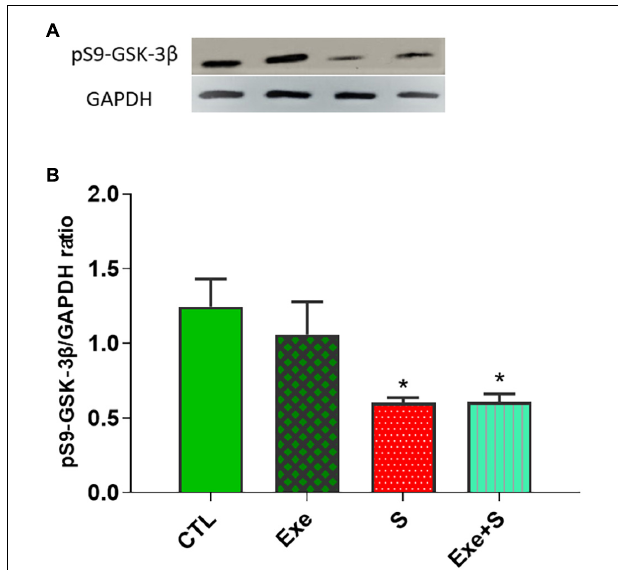
FIGURE 9 | Effects of waterpipe smoke inhalation on the expression of cardiac pS9-GSK-3 β proteins (A) and pS9-GSK-3 β / GAPDH ratio (B) in different experimental groups. CTL, control group; Ex, group subjected to exercise training for 8 weeks; S, group subjected to waterpipe tobacco smoke inhalation for 8 weeks; Ex + S, group subjected to exercise training and waterpipe tobacco smoke inahaltion for 8 weeks. The results are presented as mean ± SEM, n = (6–7). * P < 0.05 vs. CTL.